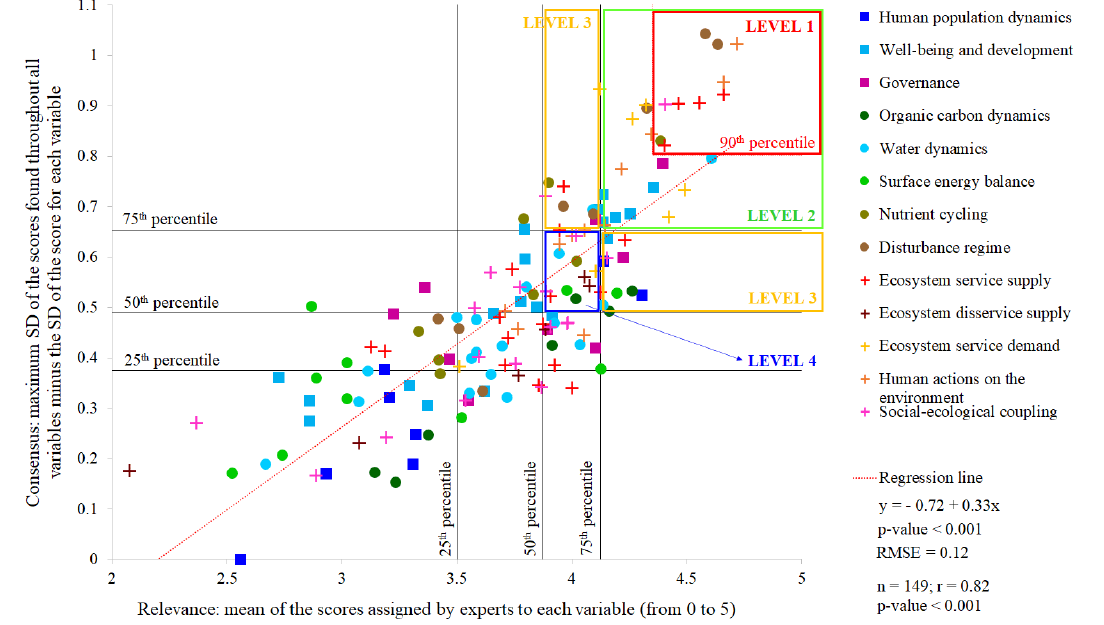
Fig. 3 . Relevance and consensus obtained by variables for characterizing and monitoring social-ecological systems (SESs) in the final survey. Relevance was evaluated as the mean of the scores assigned by experts to each variable. The consensus was estimated as the difference between the maximum standard deviation of the scores found throughout the 149 variables and the standard deviation of the score for each variable (low differences indicated low consensus and high differences, high consensus). Squares, circles, and plus signs identify the variables belonging to the social system, ecological system, and interaction components, respectively. Horizontal and vertical lines represent the 25 th , 50 th , 75 th , and 90 th percentiles of relevance and consensus. Boxes over the grid illustrate the clustering of the variables by priority levels. The red box (priority level 1) includes those variables with relevance and consensus above the 90 th percentile; the green box (level 2) includes those variables with both values between the 75 th and 90 th percentiles; the yellow box (level 3) includes those with relevance above the 75 th percentile but consensus between the 50 th and 75 th percentiles and vice versa; and the blue box (level 4) includes variables with relevance and consensus between the 50 th and 75 th percentiles. At the bottom right of the figure, the equation of the regression line, the significance of the line slope (p-value) and the root- mean-square error (RMSE) are indicated, as are the number of variables (n), the Pearson’s correlation coefficient (r), and its significance